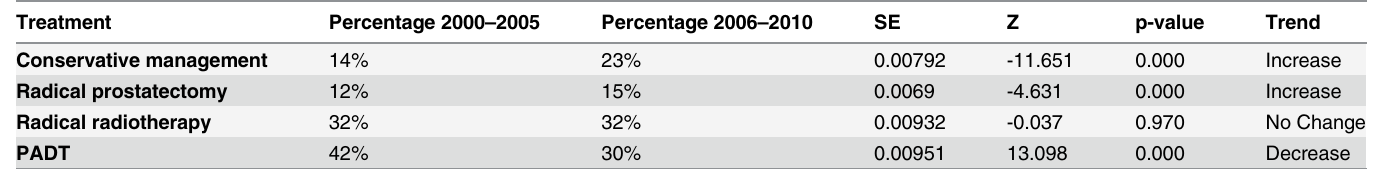
Table 1. Incidence rate changes in prostate cancer treatment modality for non-metastatic disease between 2000 – 2005 and 2006 – 20. Treatment